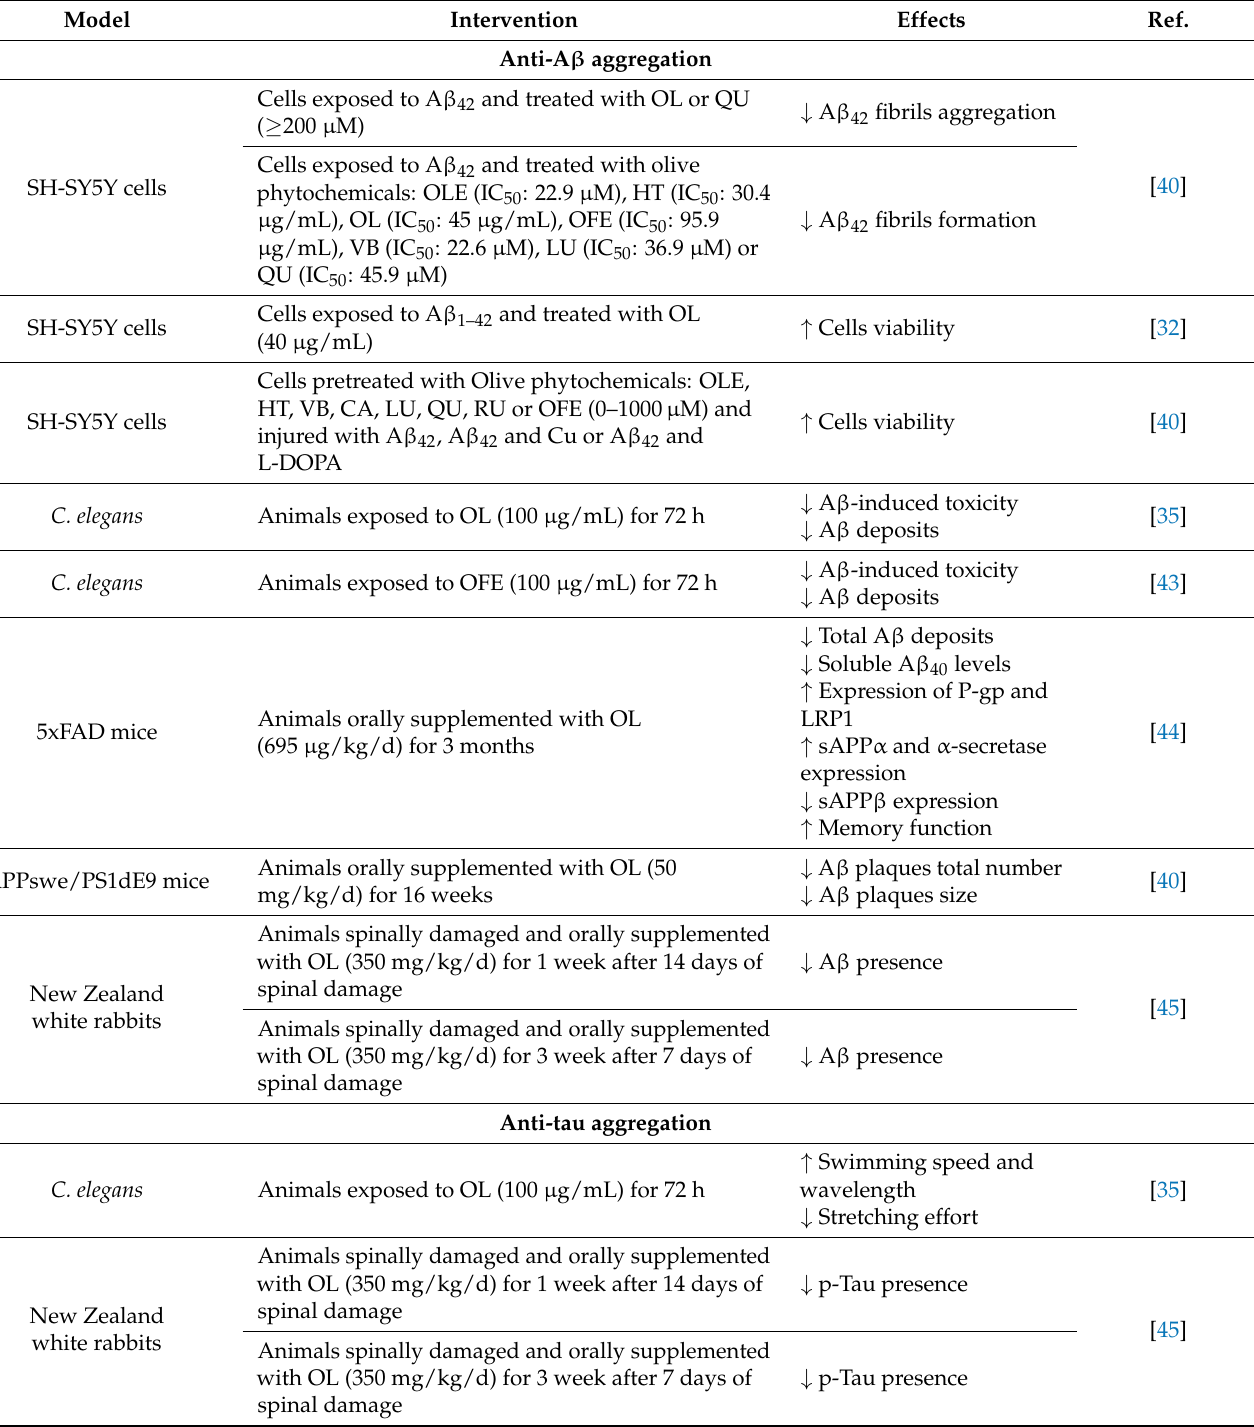
Table 3. Mechanisms of action of OL in both in vitro and in vivo